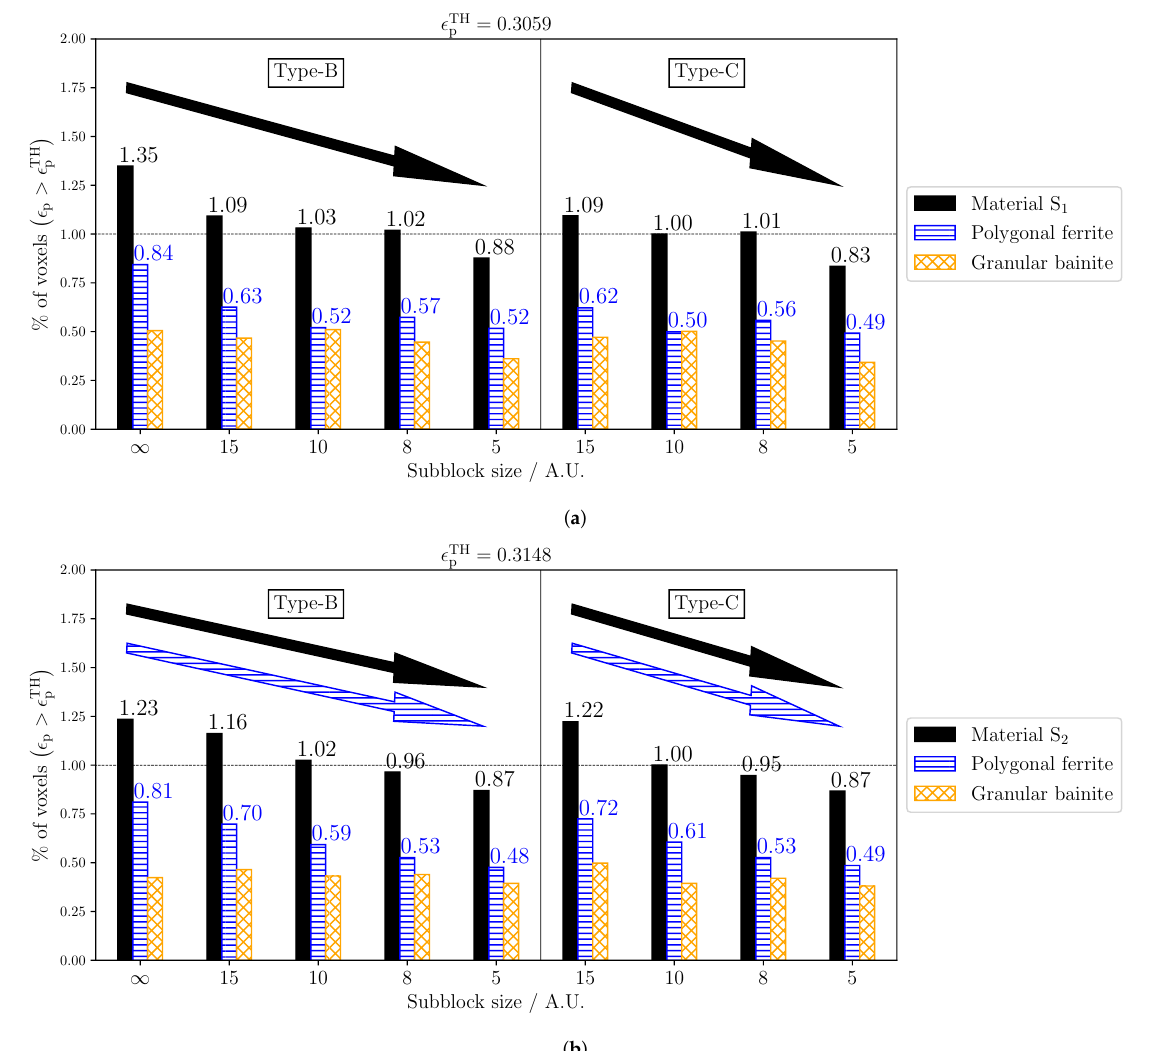
Figure 15. The ductile damage parameter based on the equivalent plastic for RVEs with microstruc- tural variations in materials S 1 ( a ) and S 2 ( b